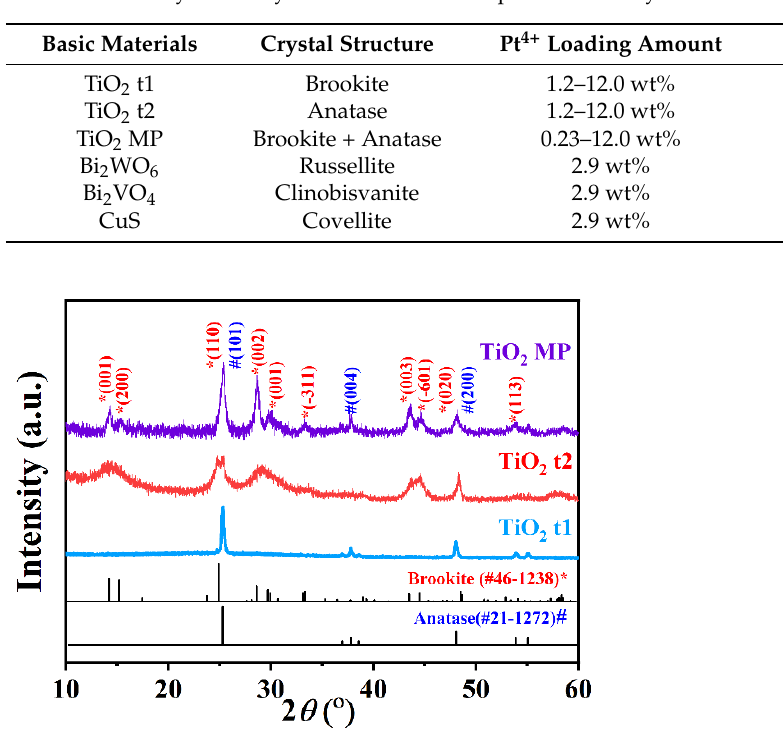
Figure 1. XRD patterns of TiO 2 MP, TiO 2 t1, and TiO 2 t2 samples. The peaks marked by pound sign and asterisk are dependent to anatase phase (JCPDS No. 21-1272) and brookite phase (JCPDS No. 46-1238), respectively.